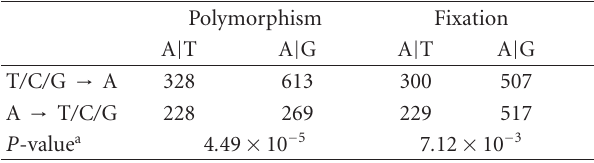
Table 3: Mutation pattern on A | U dicodon boundaries. Polymorphism